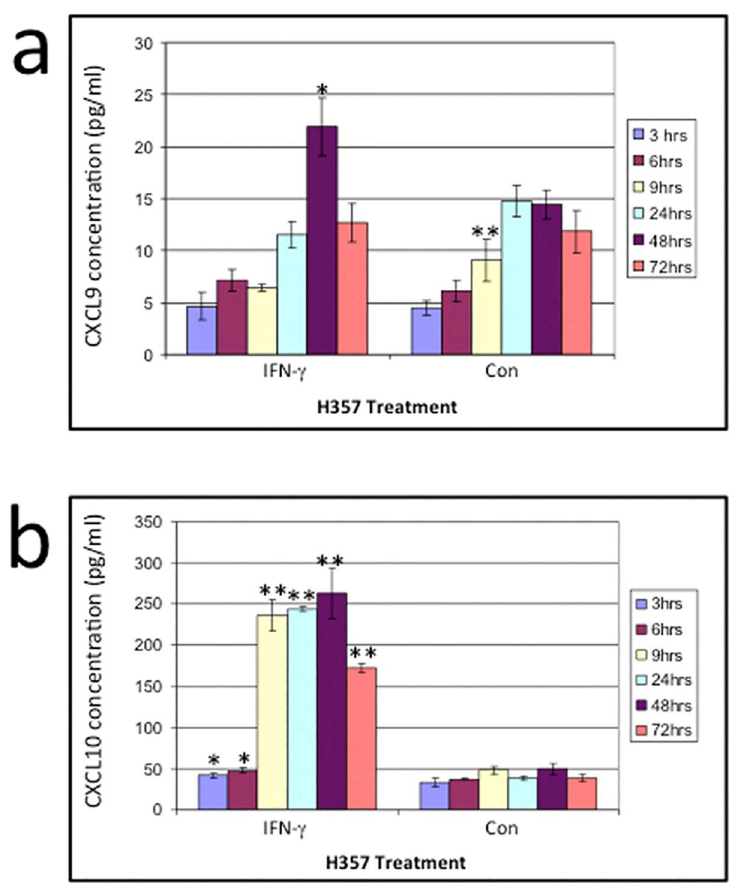
CXCL10 (Fig 6B) and CXCL11 (Fig 6C) mRNA specific bands after removing the